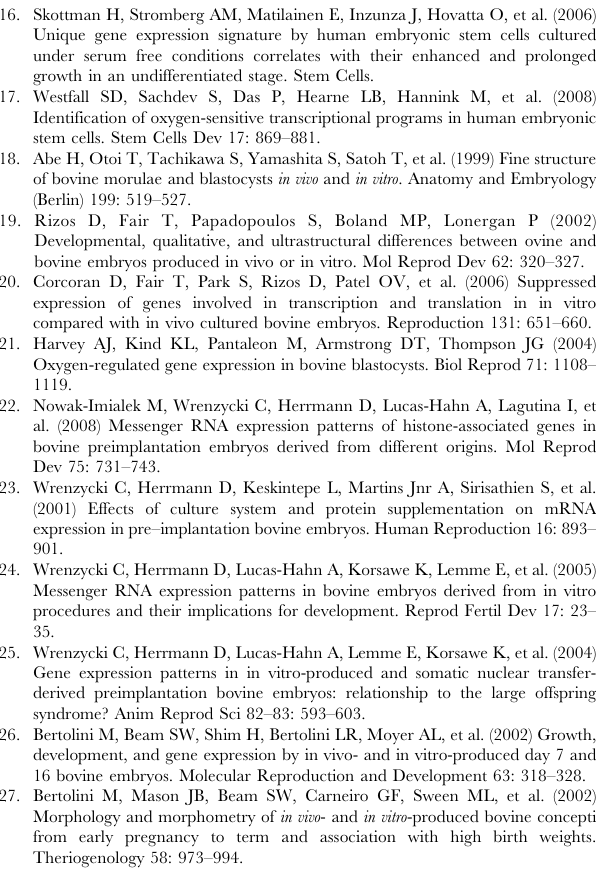
Table S4 Transcripts identified within common frameworks CTCF-HIFF, ETSF-HIFF and